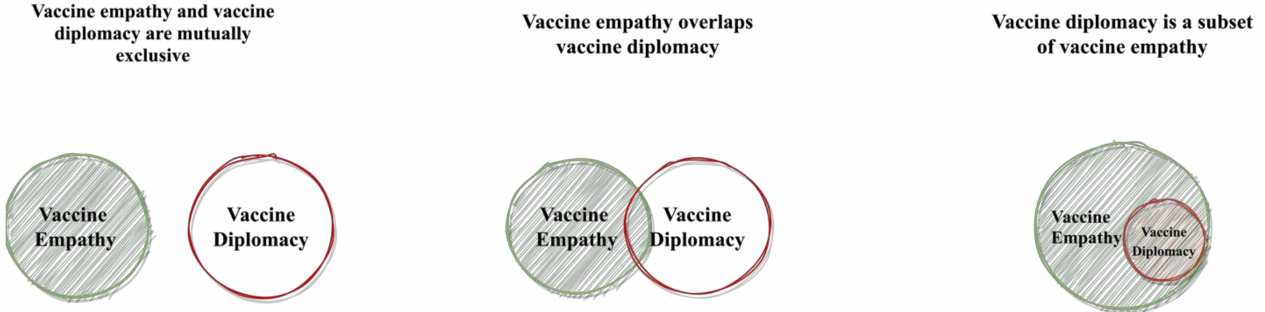
Figure 1. Paradigms for relationships between vaccine empathy and vaccine